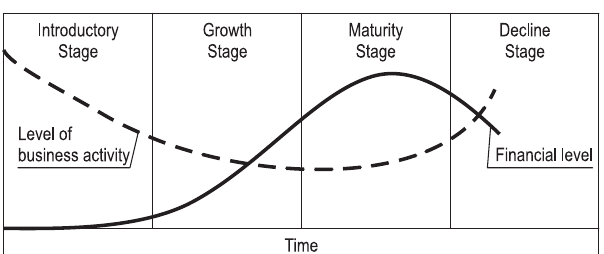
Fig. 2. Potential development of fi nancial risk for